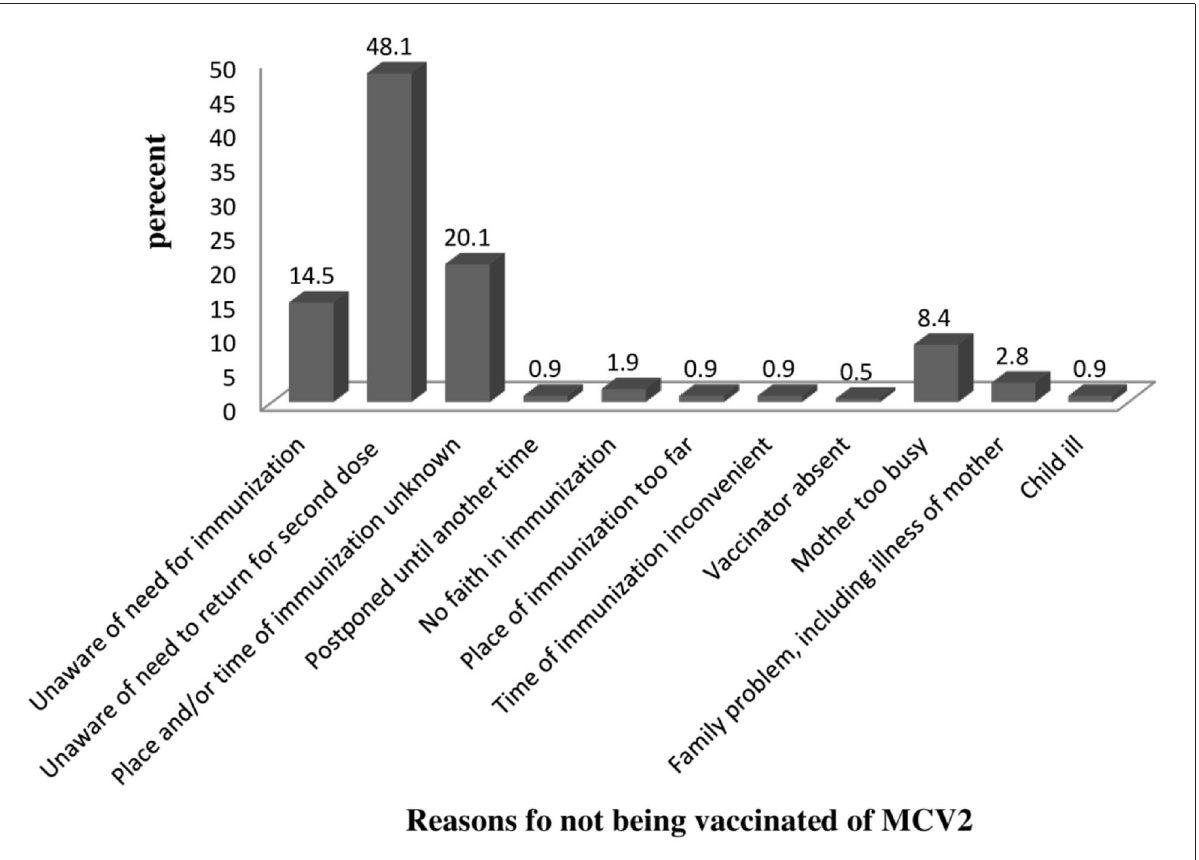
FIGURE2 Reason for not vaccinating among study participants on MCV2 vaccination and associated factors in urban areas of North Shoa, Oromia Region, 2022.